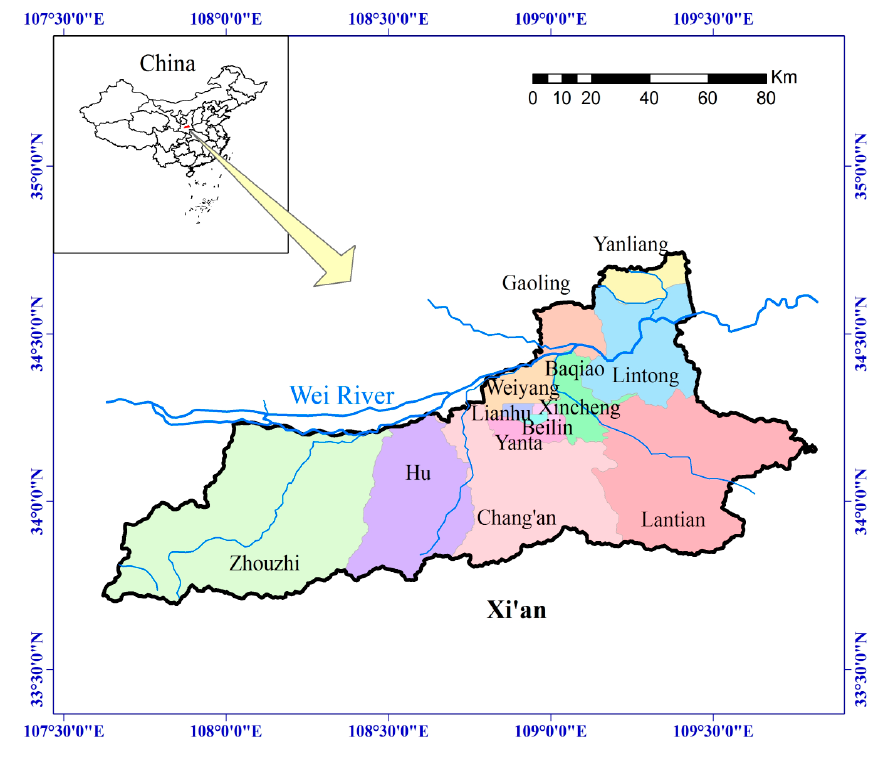
Figure 2. Study area location. Table 1. Land area and population of Xi’an city in 2014.